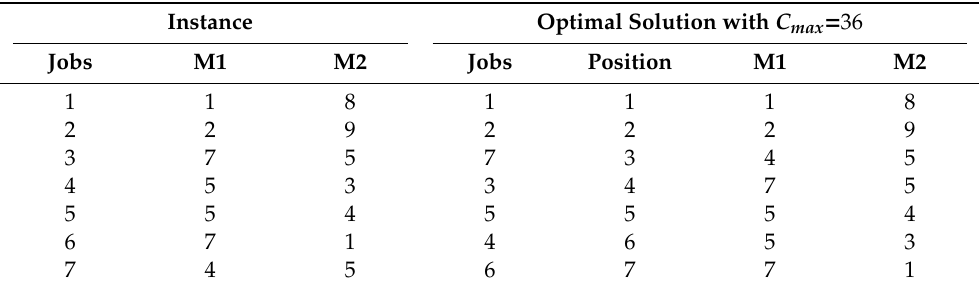
Table 1. Problem instance with processing times and optimal solution. Instance Optimal Solution with C max =